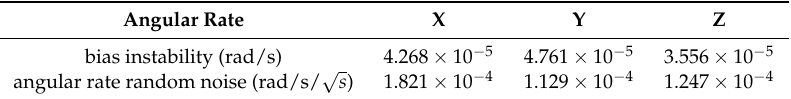
Table 4. The gyroscope performance parameters.